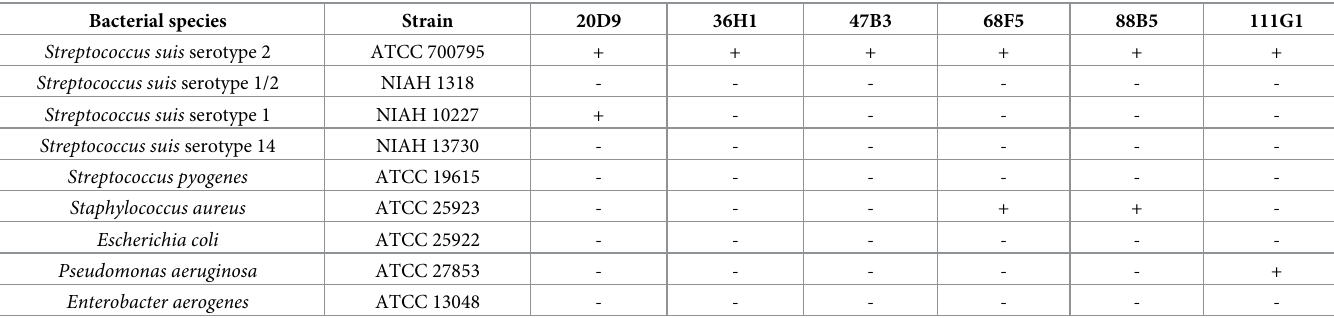
Table 2. Summary of the cross-reactivity of the six positive clones, as determined by ELISA. Bacterial species